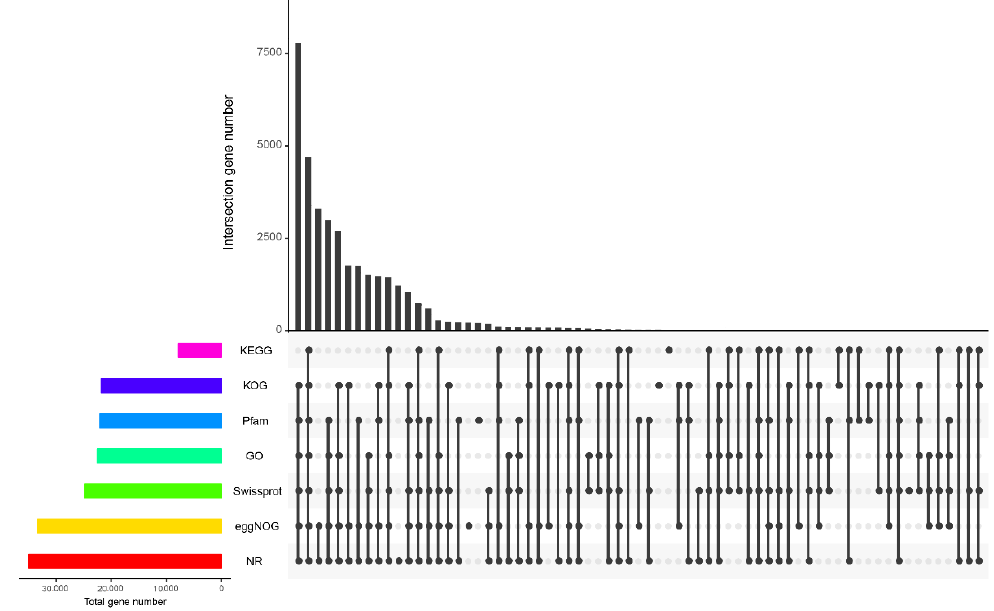
Figure 2. Each database annotates a Venn diagram.